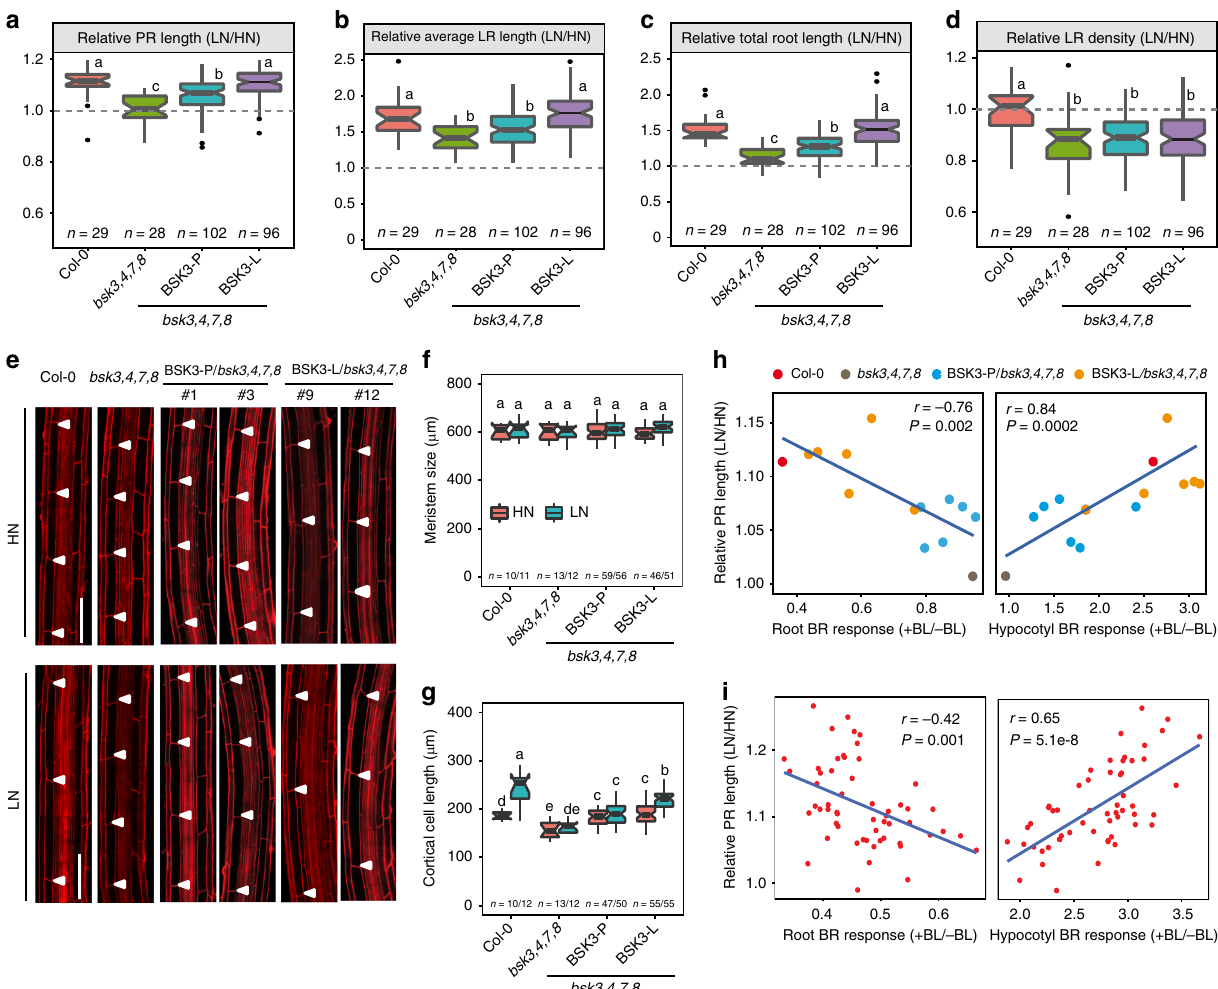
Fig. 5 BSK3-dependent BR sensitivity tunes root responses to low N. a – d Response to low N of Col-0, bsk3 , 4 , 7 , 8 , and independent transgenic plants expressing the sequences coding for either the BSK3-P or BSK3-L variant under control of the BSK3 Col-0 promoter. Relative change of primary root length ( a ), average lateral root length ( b ), total root length ( c ), and lateral root density ( d ) in response to low N. e Representative confocal images of mature cortical cells of wild-type (Col-0), bsk3 , 4 , 7 , 8 transgenic lines complemented with either BSK3 variants under BSK3 Col-0 promoter (two representative lines for each construct are shown). White arrowheads indicate two consecutive cortical cells. Scale bars, 100 μ m. f , g Length of meristems ( f ) and mature cortical cells ( g ) of wild-type (Col-0), bsk3 , and allelic complementation lines in bsk3 , 4 , 7 , 8 mutant grown under HN or LN. Root system architecture and cellular traits were assessed after 9 days. Horizontal lines show medians; box limits indicate the 25th and 75th percentiles; whiskers extend to 5th and 95th percentiles. Different letters indicate signi fi cant differences at P < 0.05 according to one-way ANOVA and post-hoc Tukey ’ s test. h , i Correlation between BR-dependent root or hypocotyl elongation and the responsiveness to LN of primary root in BSK3 allelic variant complemented lines ( h ) and natural accessions ( i ). The data used for the correlation analyses derived from experiments shown in Fig. 1a, Fig. 4b – e and Fig.